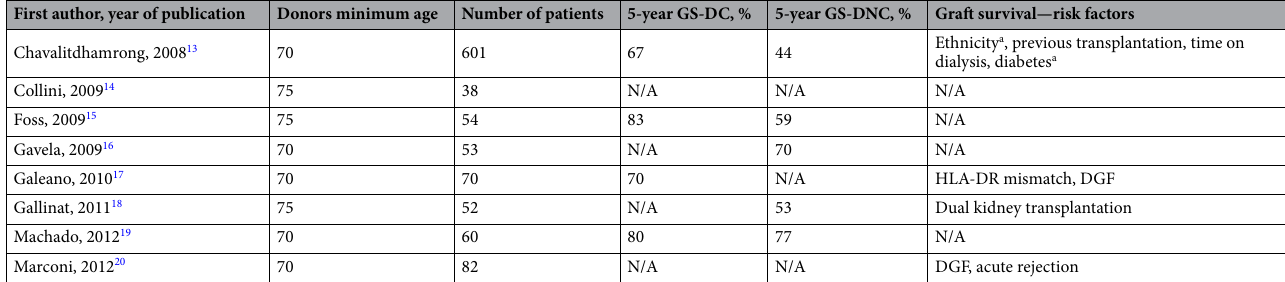
Table 6. Overview of published cohorts on donors aged more than 70 or 75 years old. N/A non appliable, DGF delayed graft functioning, GS-DC graft survival censored for death, GS-DNC graft survival non censored for death. a Related to the